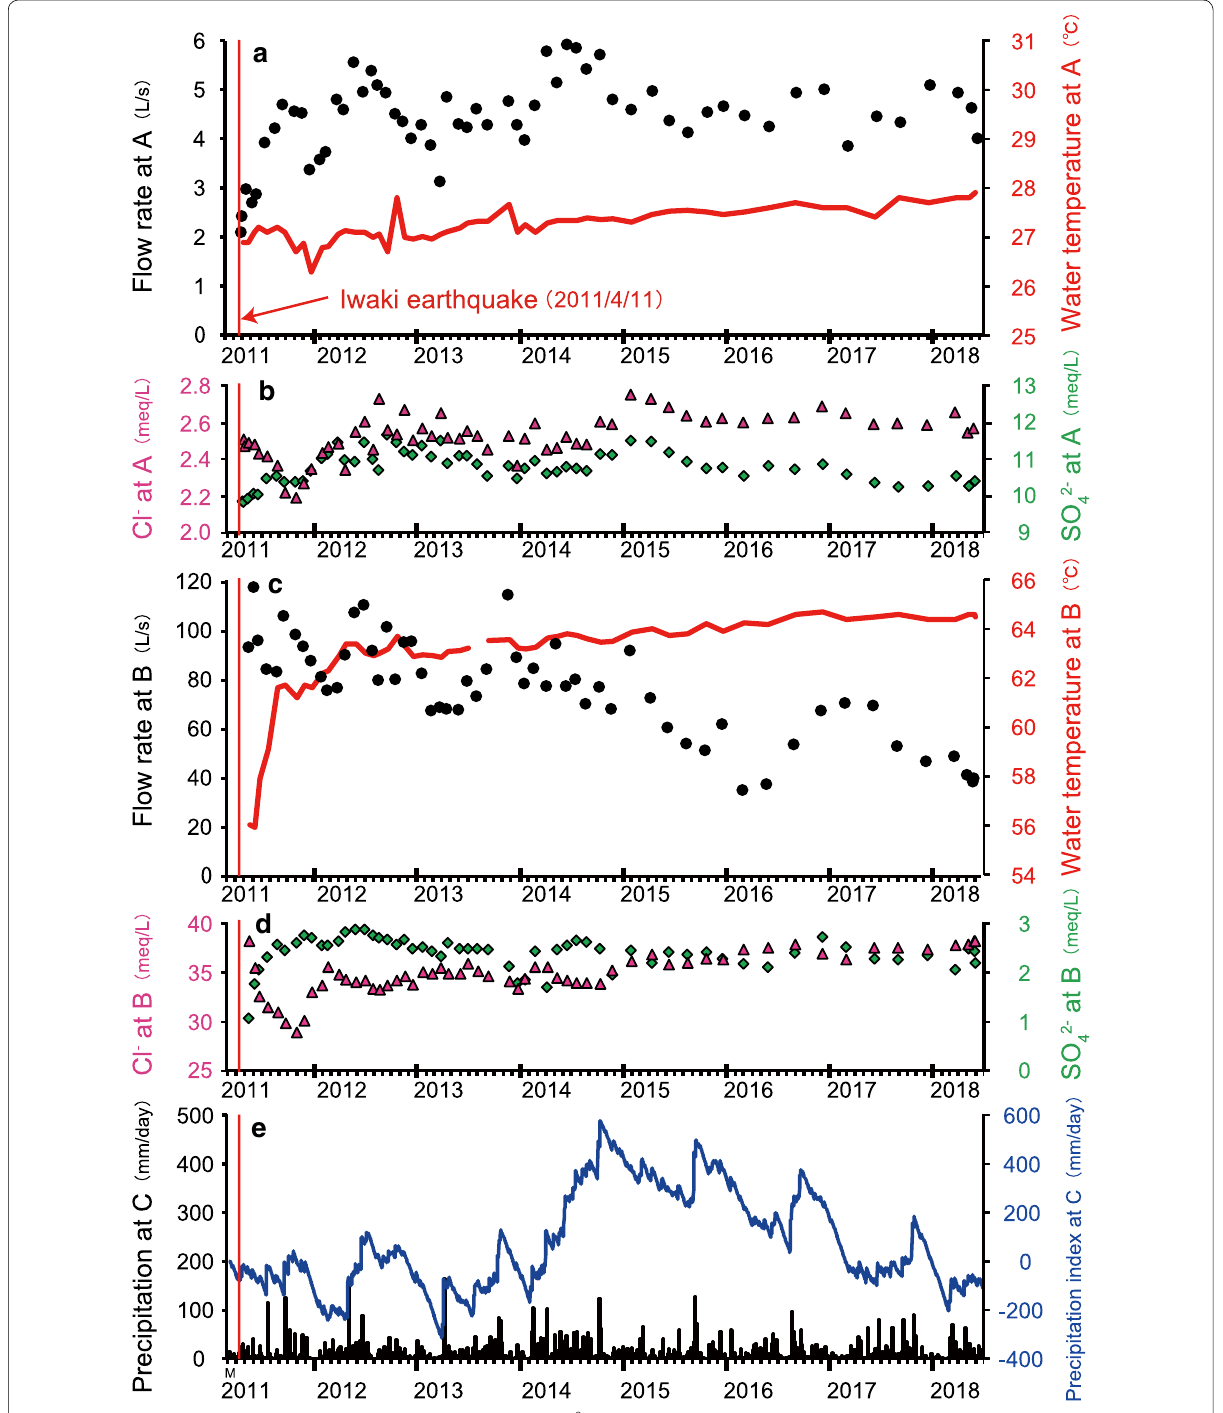
Fig. 5 Temporal variations in flow rate, temperature, and Cl − and SO 42 − concentrations at sites A and B ( a – d ). Precipitation data from Japan Meteorological Agency (2019), where blue line ( e ) shows precipitation index calculated by subtracting integrated value of average daily precipitation from accumulated daily